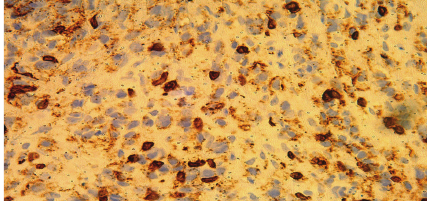
Figure 6: CD23 40x. Mediastinal large B-cell lymphoma biopsy CD23